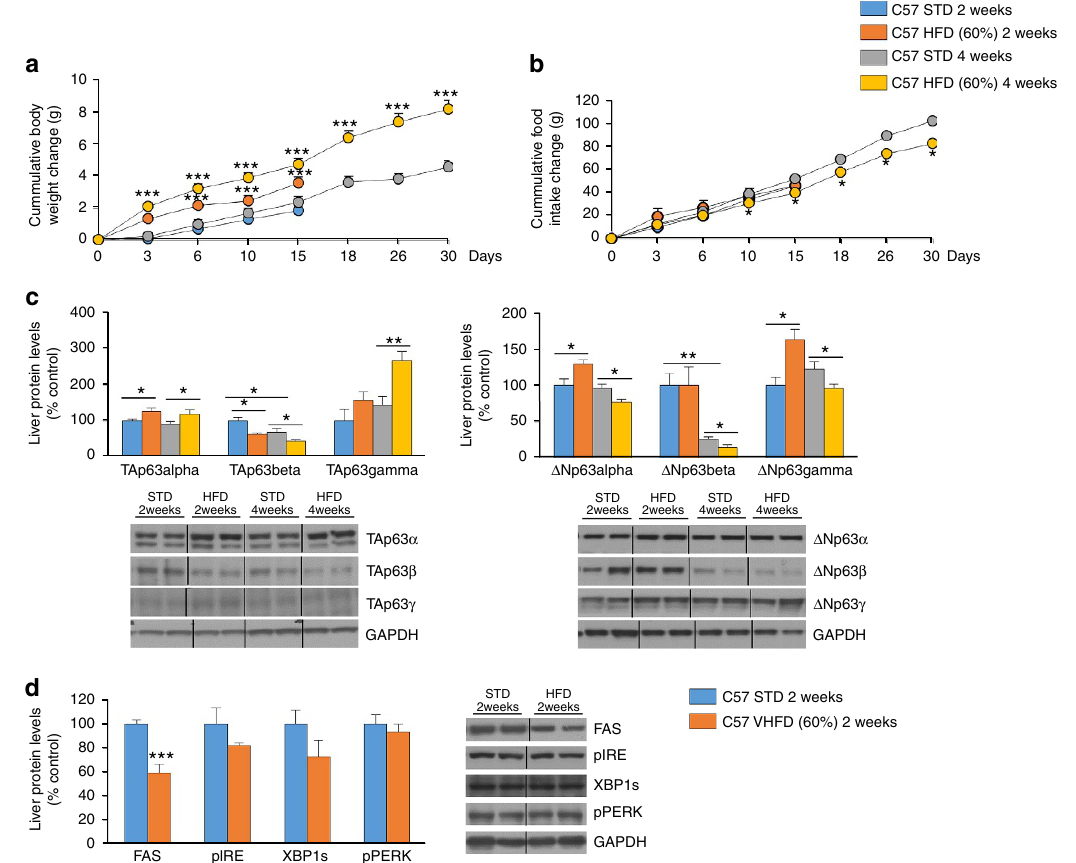
Figure 4 | High fat diet increases hepatic TAp63 a . ( a ) Body weight; ( b ) cumulative food intake ( n ¼ 10 per group); ( c ) protein levels of TAp63 and D Np63 isoforms; and ( d ) protein levels of FAS, pIRE, XBP1s and pPERK in the liver of mice fed a high fat diet during 2 and 4 weeks ( n ¼ 6 per group). GAPDH was used to normalize protein levels. Dividing lines indicate splicings in the same gel. Uncropped blots of this Figure accompanied by the location of molecular weight markers are shown in Supplementary Fig. 13. Data are presented as mean ± standard error mean (s.e.m.). Statistical significance, * P o 0.05, ** P o 0.01 and *** P o 0.001. For multiple comparison ( a – c ) a one way ANOVA followed by Bonferroni or Kruskal-Wallis test was performed. Student t -test was used in western blot ( d ) comparing STD and VHFD 2 weeks.